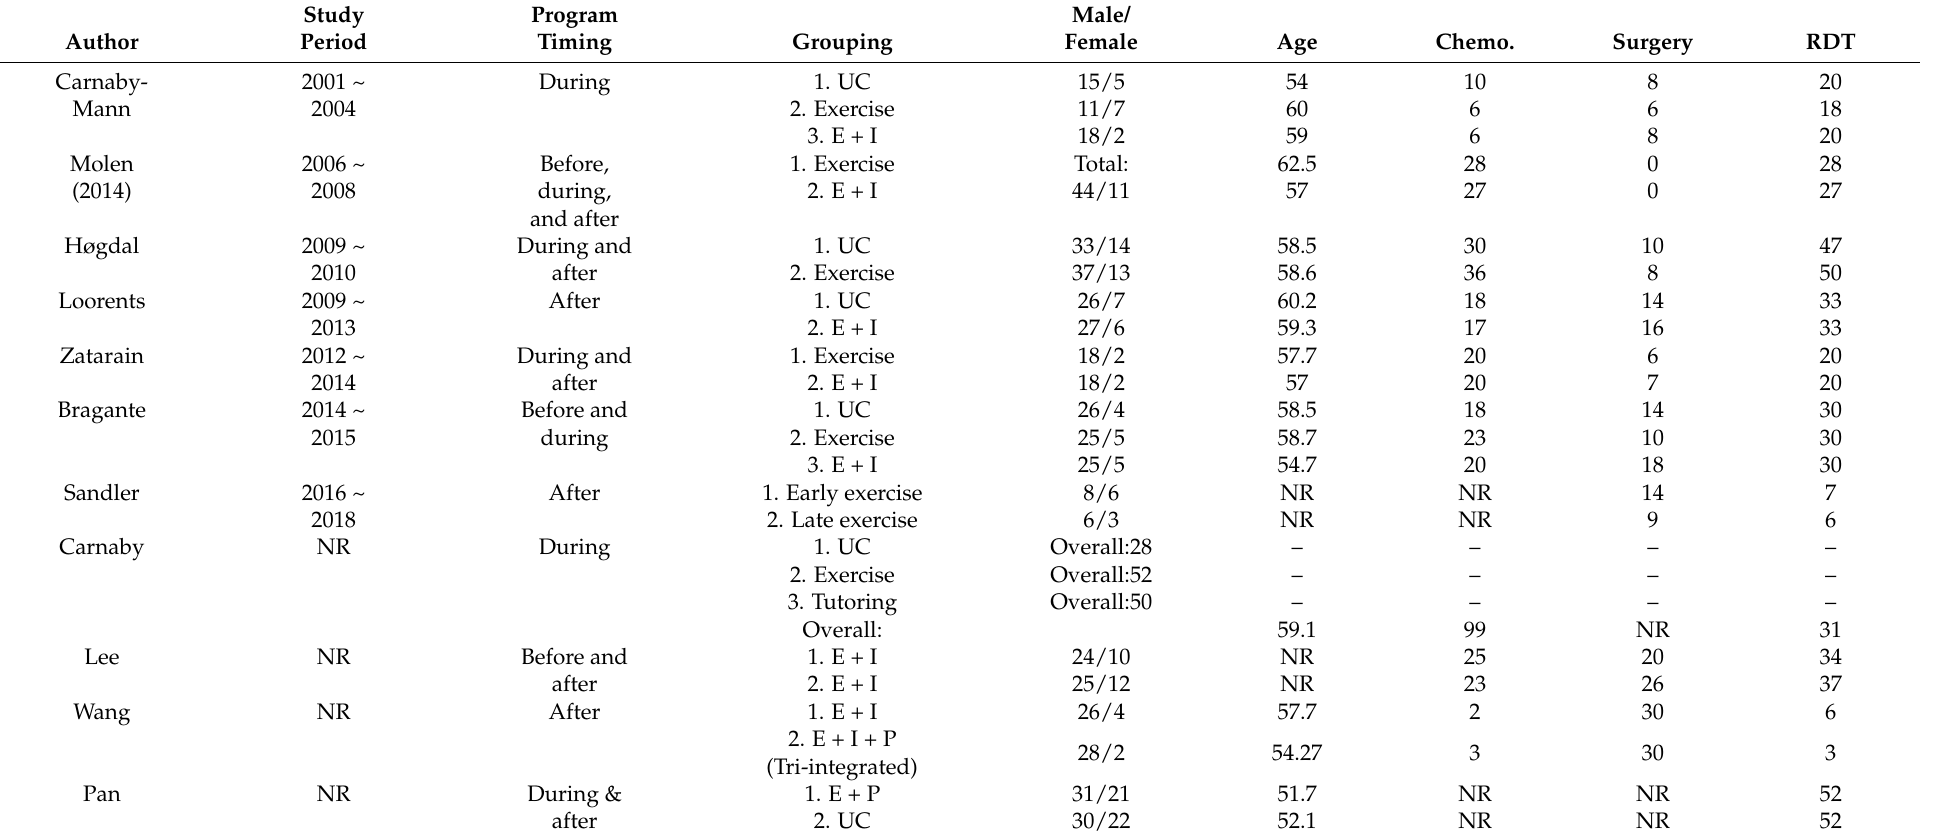
Table 1. Characteristics of the included randomized controlled